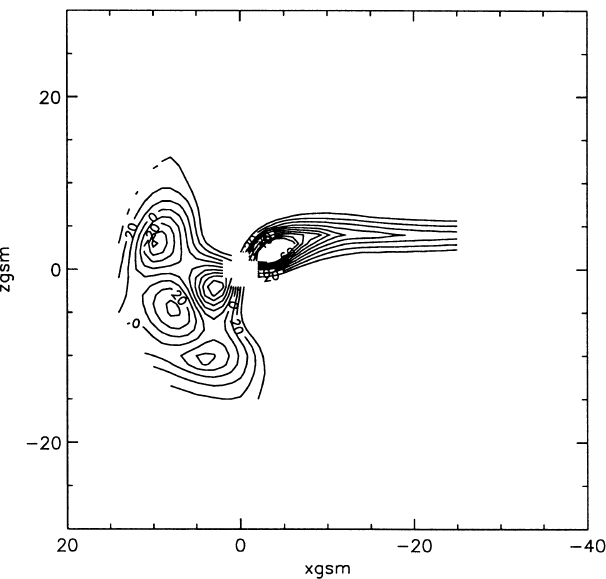
Fig. 12. Same as Fig. 11 but for a geomagnetic activity level Kp = 5. Eastward and westward currents are enhanced by a factor two